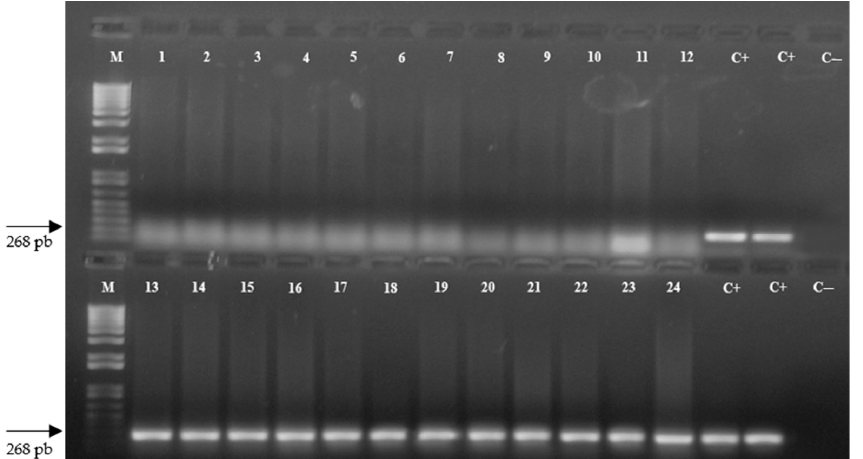
Figure 1. PCR amplification of the 268 bp DNA fragment of the stx IA gene integrated in the Pera sweet orange genome. Lanes: M, molecular marker; 1–12, non-transgenic Pera sweet orange plant (control); 13–15, plants of the STX-5 transgenic line; 16–18, plants of the STX-11 transgenic line; 19–21, plants of the STX-12 transgenic line; 22–24, plants of the STX-13 transgenic line; C+, positive control using the pST10 plasmid containing the stx IA gene; and C–, negative